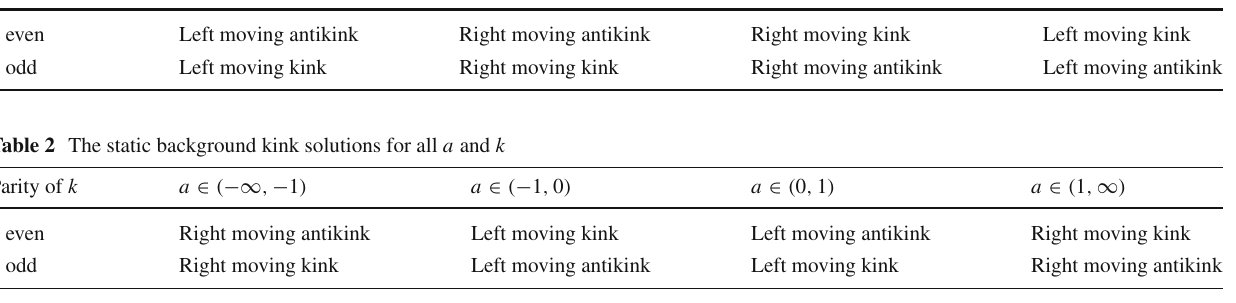
Table 1 The translationally invariant background kink solutions for all a and k Parity of k a ∈ ( −∞ , − 1 ) a ∈ ( − 1 , 0 ) a ∈ ( 0 , 1 ) a ∈ ( 1 , ∞ ) k even Left moving antikink Right moving antikink Right moving kink Left moving kink k odd Left moving kink Right moving kink Right moving antikink Left moving antikink